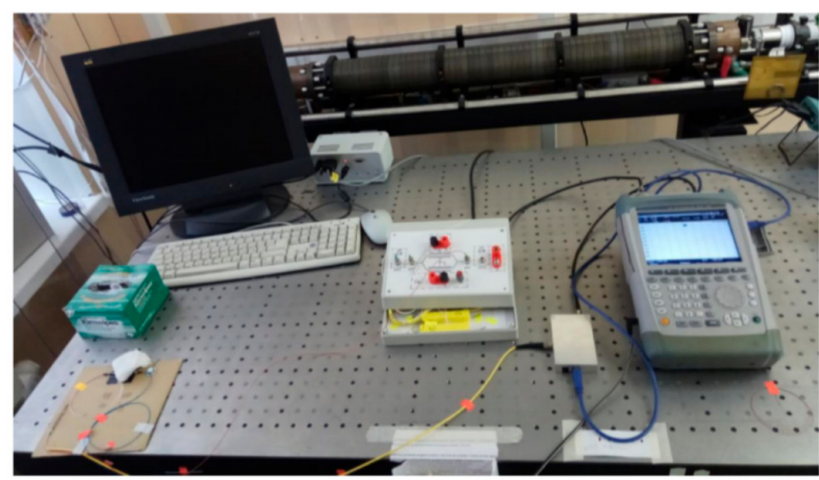
Figure 17. The model of described